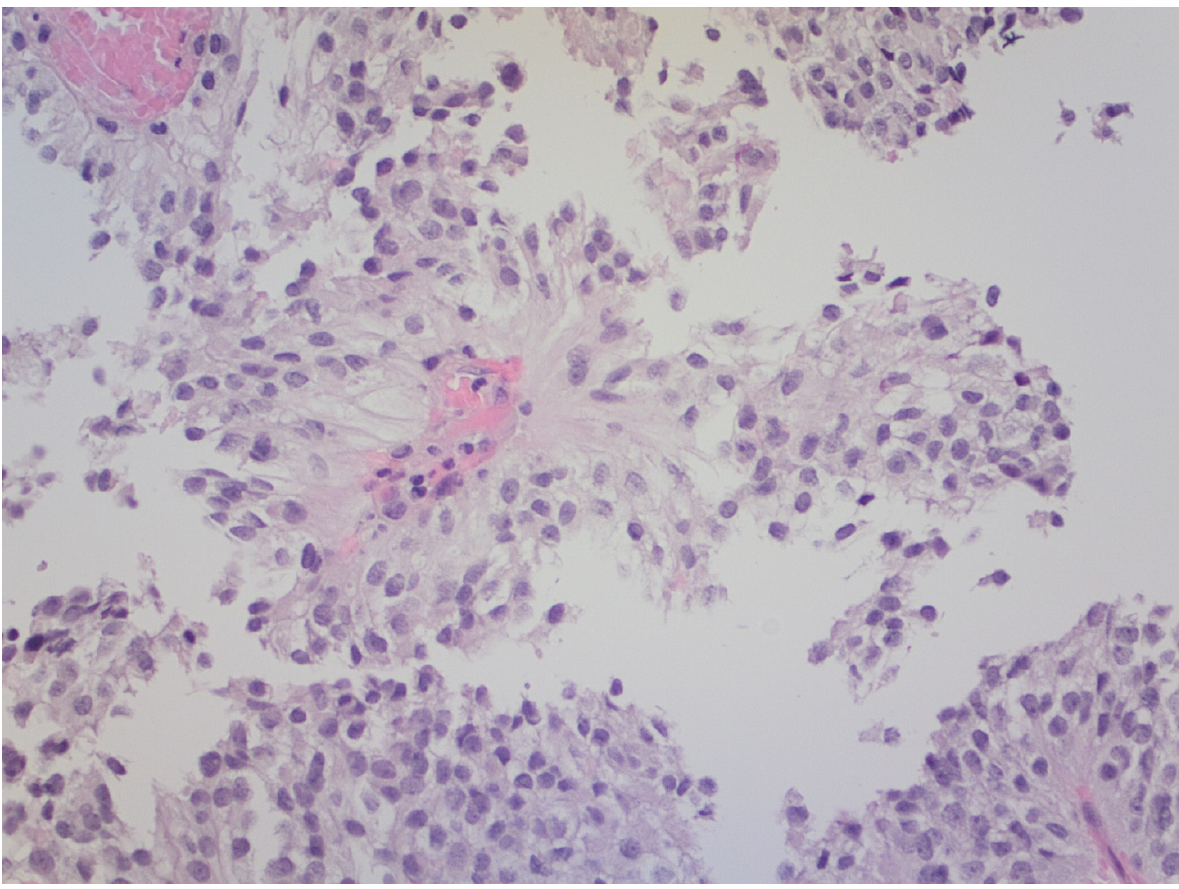
Figure 3. Hematoxylin-eosin staining ×20. PTPR with prominent papillary architecture. The vessels are covered by layers of large, eosinophilic columnar cells. The nuclei are round to oval, with stip- pled